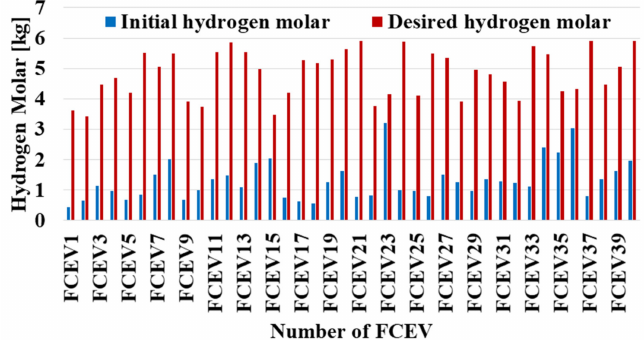
Figure 6. Initial and desired hydrogen molar amounts of FCEVs.